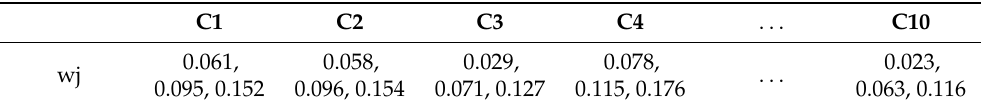
Table 5. Weight coefficients in the form of fuzzy numbers.